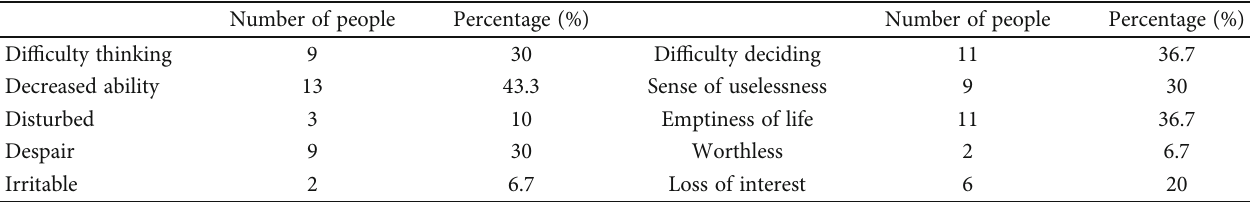
Table 3: Frequency and percentage of SDS total score and single factor score